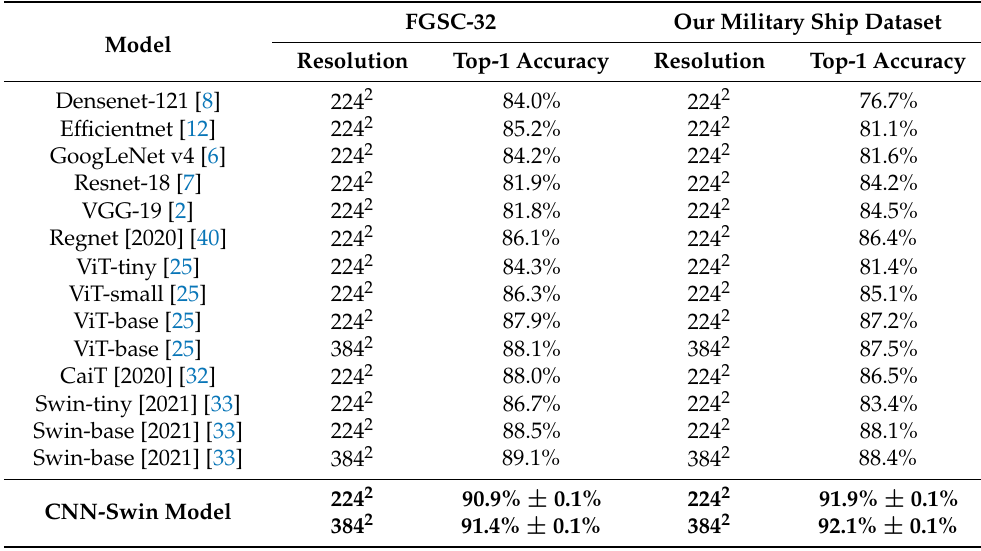
Table 3. Comparison with state-of-the-art approaches for image